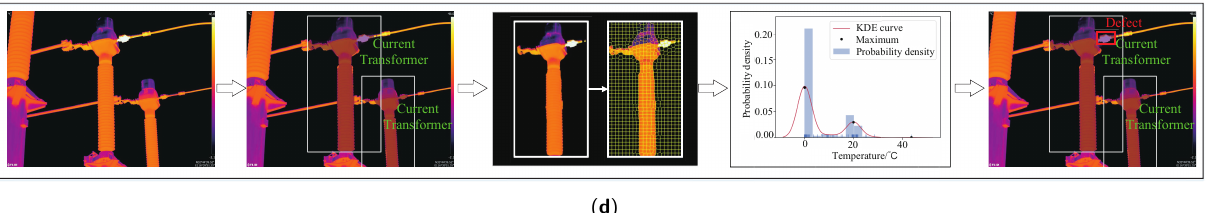
Figure 9. Process of the defect infrared image detection. ( a ) Insulator. ( b ) Bushing. ( c ) Voltage Transformer. ( d ) Current